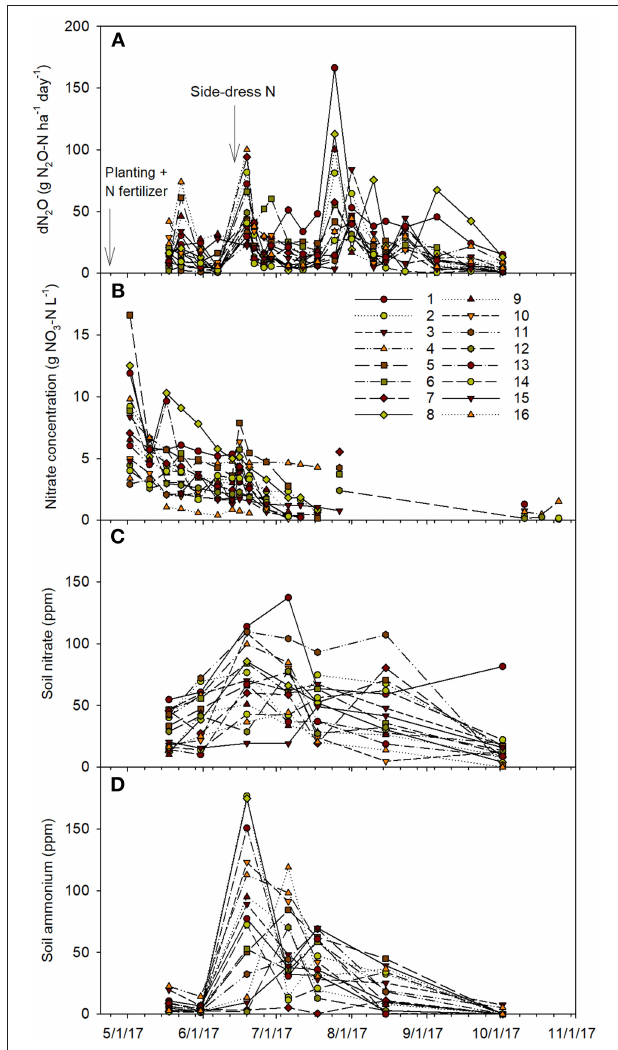
FIGURE 3 | Daily nitrous oxide fluxes (dN 2 O) (A) , tile drainage nitrate concentration (B) , soil nitrate (NO 3 -N) (C) , and ammonium (NH 4 -N) concentration (D) during the 2017 corn growing